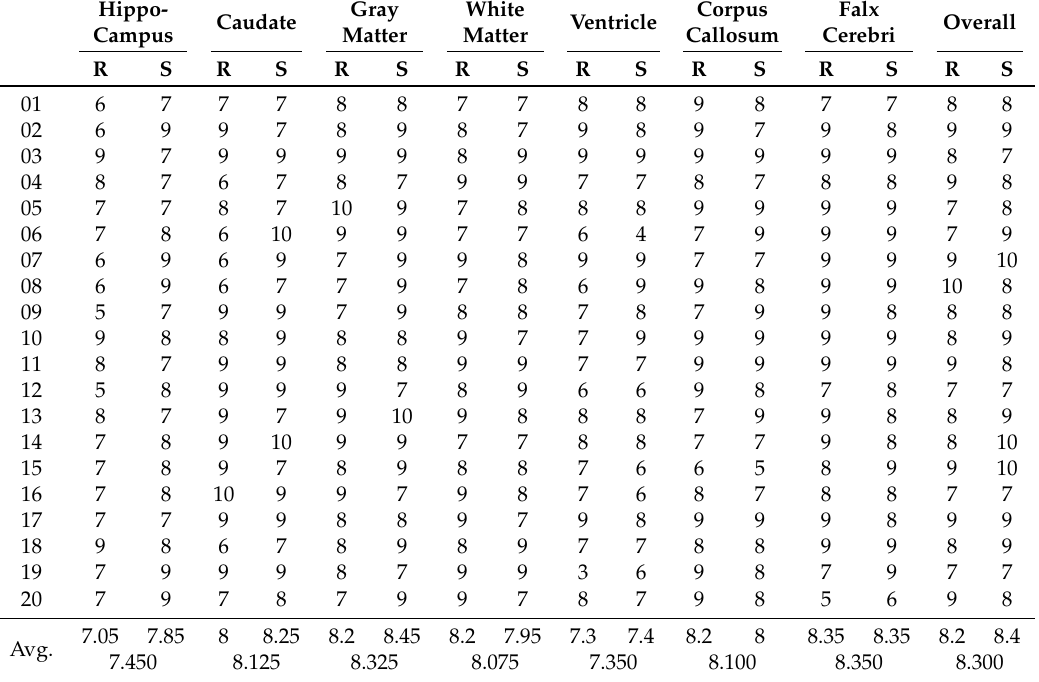
in Table 5. The following features are subdivided: hippocampus, caudate, gray matter, white matter, ventricle, corpus callosum, falx cerebri, and overall similarity. For each feature, we randomly select 20 image pairs from the test dataset. The reference MR image, estimated MR image, and corresponding CT image are shown simultaneously. A radiologist and a senior surgeon mark the similarity for each feature from 1 to 10. A higher score represents that the medical experts consider the structure between the estimated and reference MR images are much more similar. Among all features, those with the highest similarity are flax cerebri (8.350), gray matter (8.325), and overall similarity (8.300). In addition, hippocampus (7.450) and ventricle (7.350) have the lowest average similarity due to the small regions occupied and the subtle changes of the Hounsfield unit and small regions in CT scans. Table 5. Qualitative similarity between the reference and estimated MR images. One radiologist and one senior surgeon evaluate the similarity. The radiologist is abbreviated as R, and the senior surgeon is abbreviated as